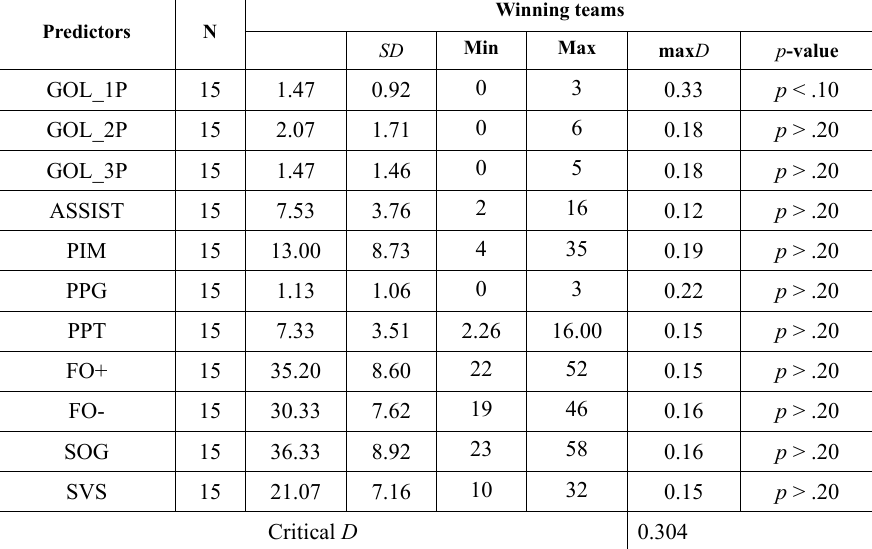
tional efficiency parameters of winning